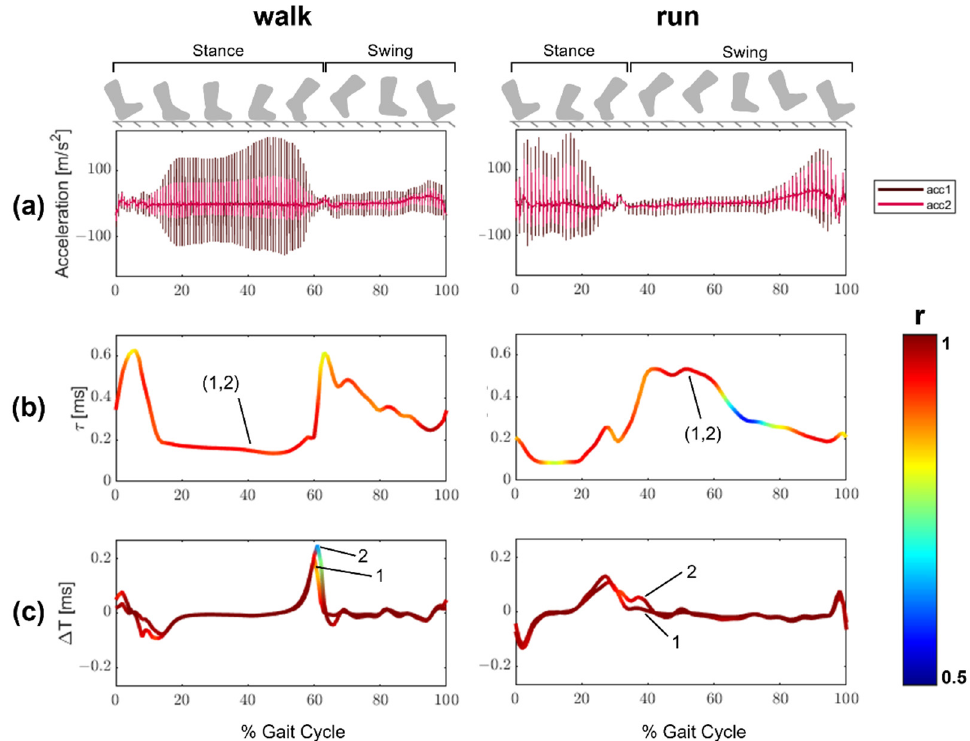
Figure 10. ( a ) Raw tensiometer data (two accelerometers) from the Achilles tendon for an example stride of walking and running. The amplitude of the measured accelerations varies in a regular patter with fluctuations of the muscle state and ankle angle throughout the gait cycle. ( b ) Stride-average estimates of the wave travel time ( τ ) between accelerometers. ( c ) Stride averaged variations in the change in wave arrival ( ∆ T ) for each accelerometer during walking and running. The line colors in ( b , c ) indicate the magnitude of the correlation coefficient ( r ) at that point in the gait cycle. Note that the cross-correlation template for event k was defined using a 2 ms window centered at the arrival time 𝑇 computed for the previous Kalman iteration 𝑘 − 1 .